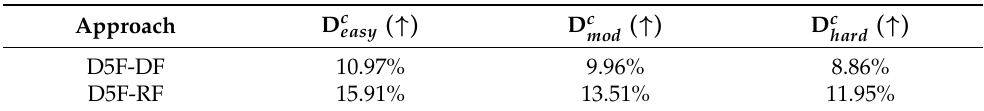
Table 3. Average precision in terms of center distance for three difficulty levels ( D c easy , D c D c ). hard